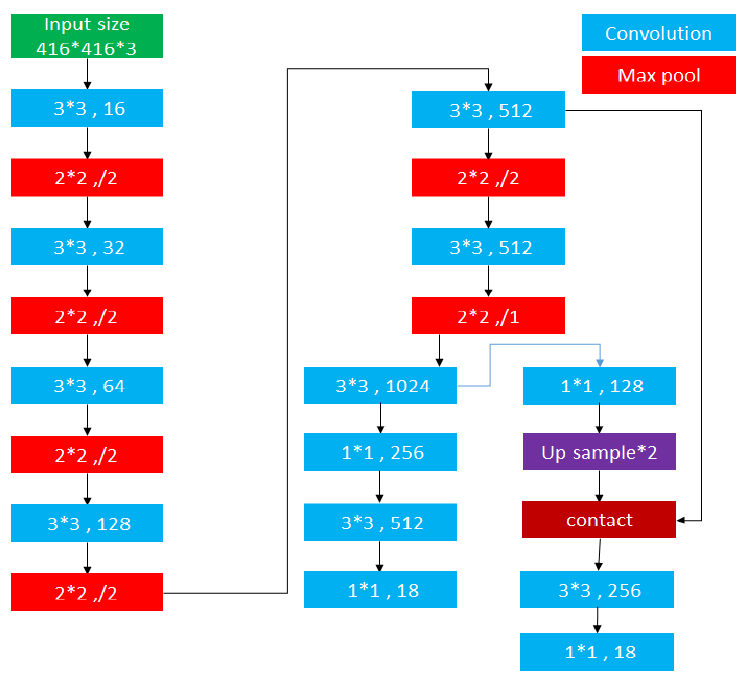
Figure 7. The network architecture of the original YOLOv3-tiny model.